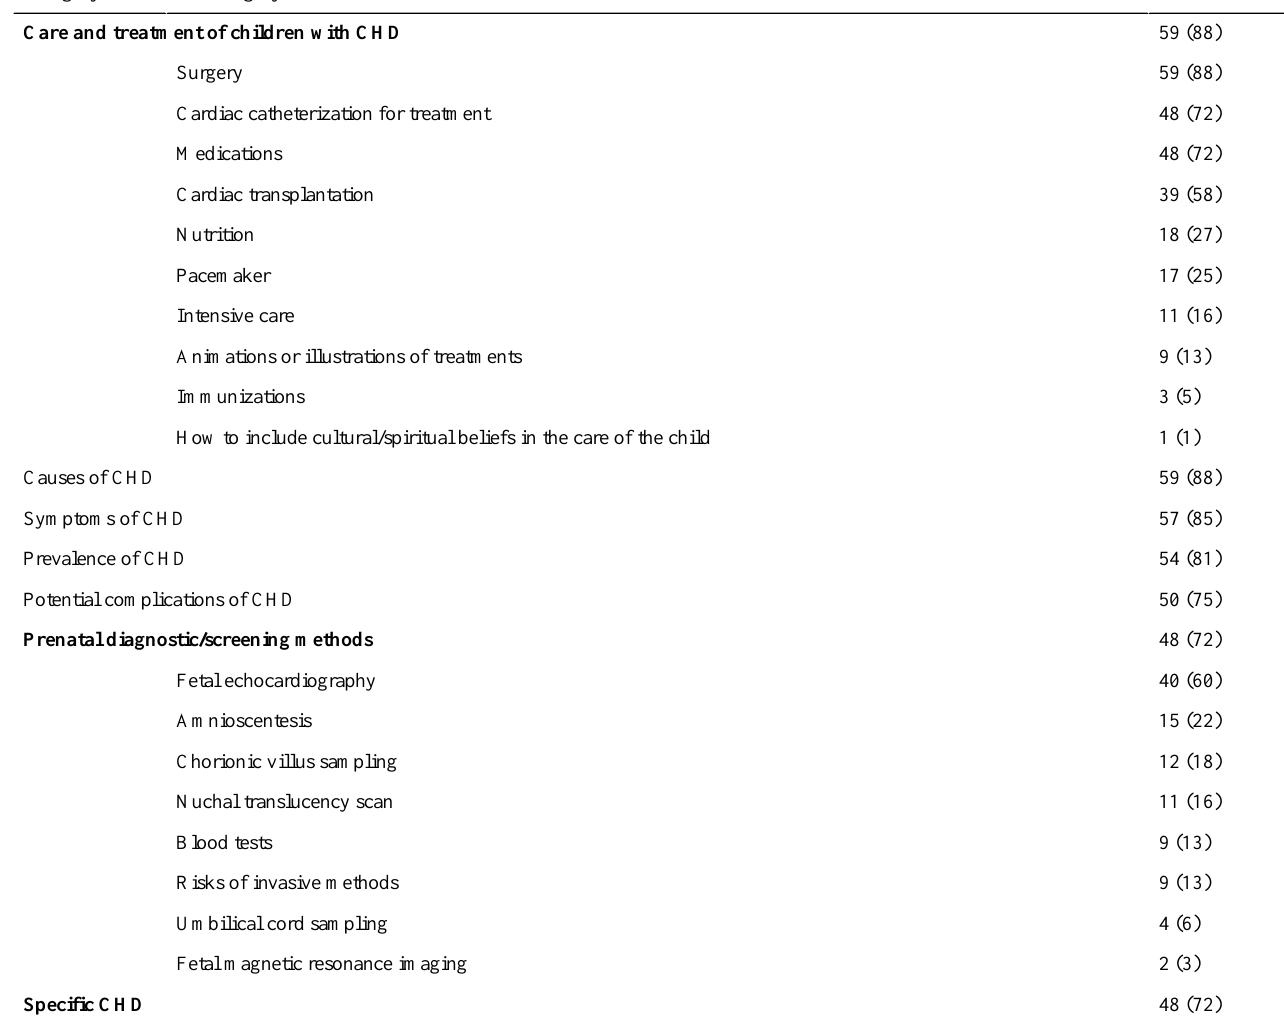
Table 1. Central subjects of content identified on the included websites